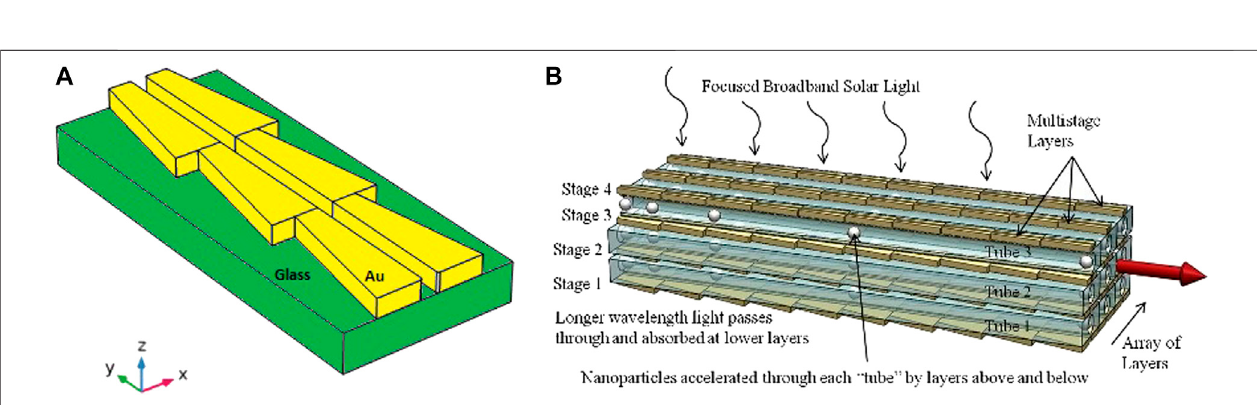
FIGURE 11 | (A) Electric fi eld distribution in a trapezoidal structure the wave is polarised along x at wavelength 532 nm; (B) electric fi eld distribution of a modi fi ed oblique-sided trapezoidal structure with the wave polarised along x and at wavelength 580 nm. © 2019 IEEE. Reprinted, with permission, from Zhang et al. (2019).